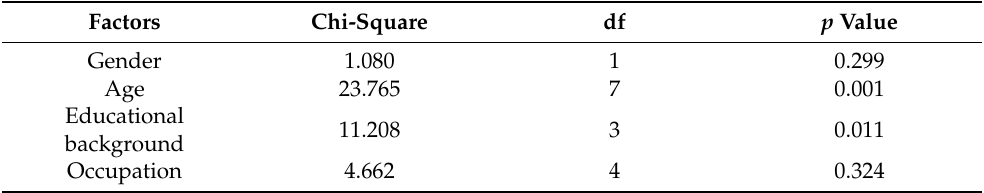
Table 7. Factors affecting choice to consume insects in KZN, South Africa.